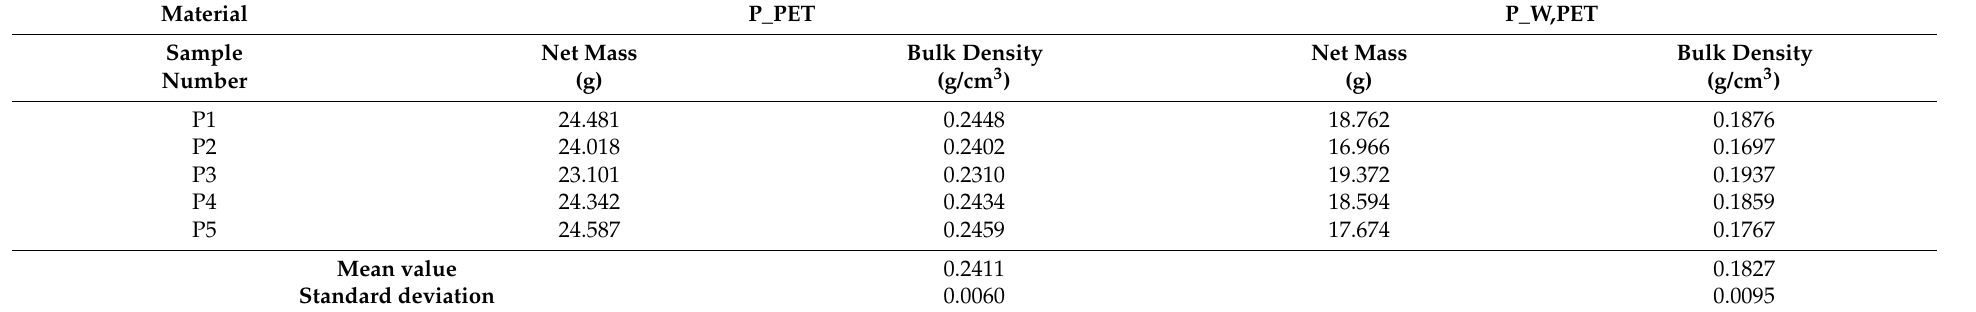
Table A51. Results of bulk density tests of P_PET and